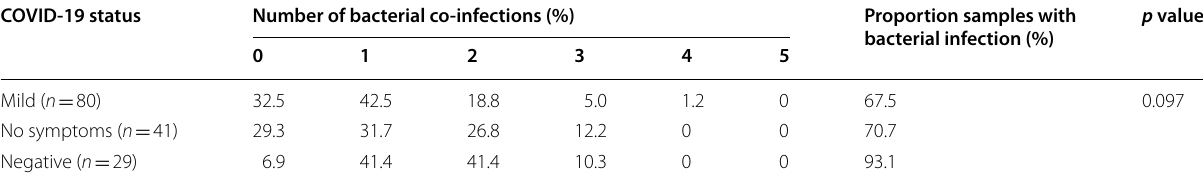
*Significant at 5% level